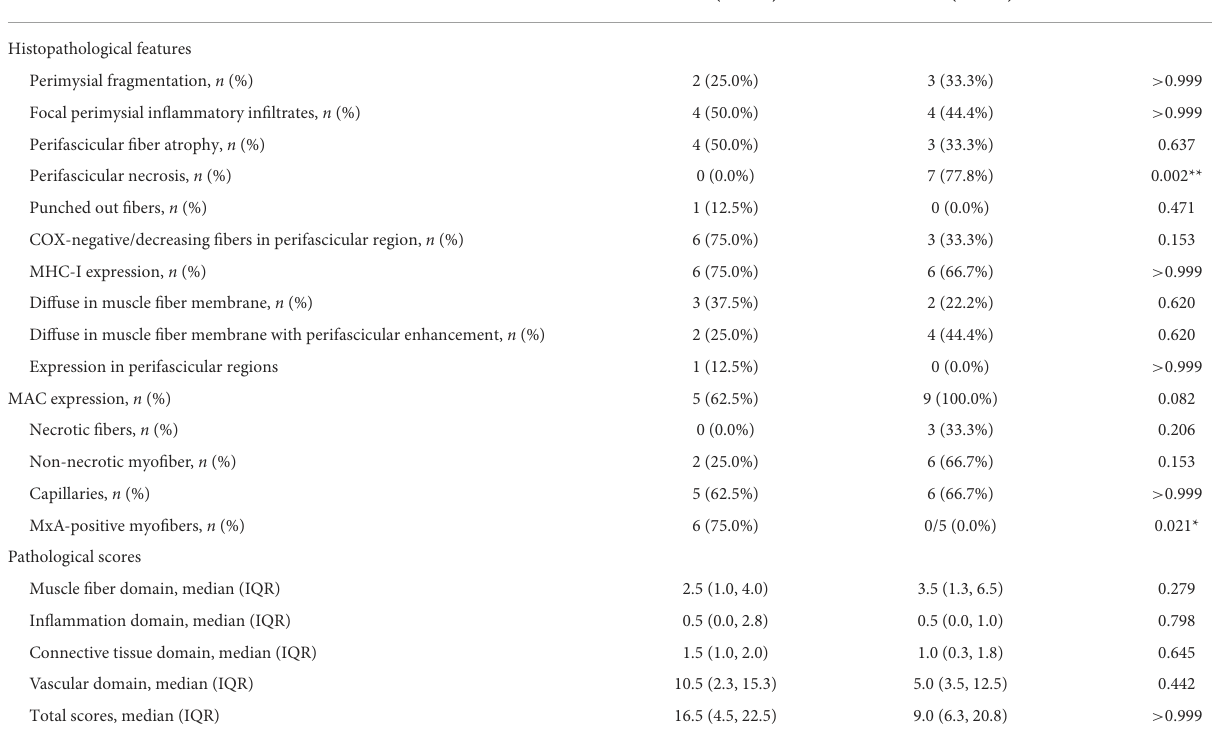
TABLE 2 Histopathological findings of patients with DM and